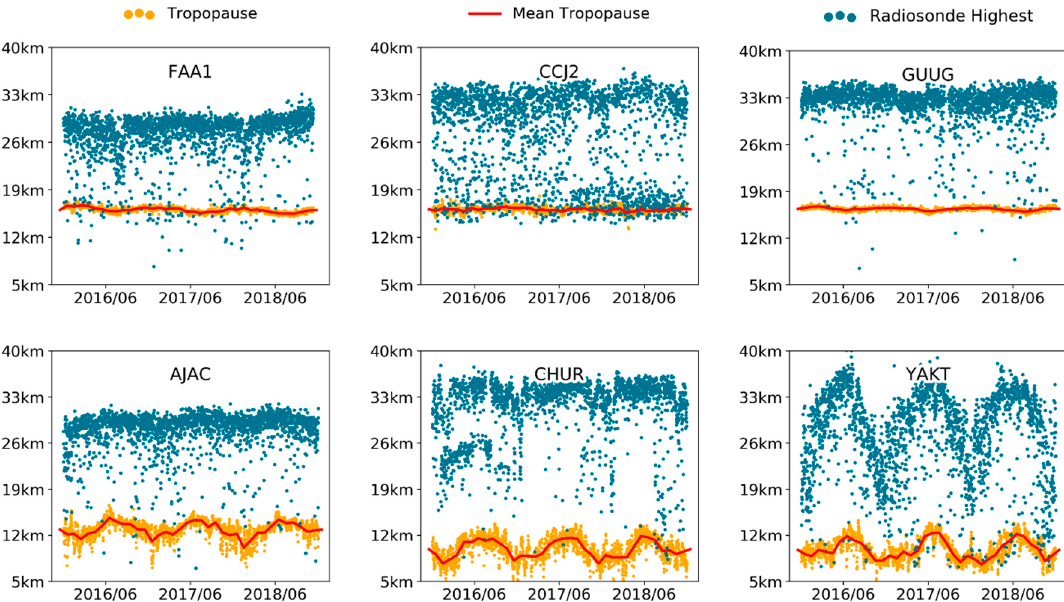
Figure 2. Example of data rejection for incomplete records by using monthly mean tropopause height estimates. Tropopause raw (in yellow), mean tropopause (in red), and highest radiosonde altitude (in blue) are shown for the stations of FAA1 on Tahiti island in the southern Pacific, CCJ2 on Ogasawara Islands in Japan, GUUG in Guam in the western Pacific, AJAC in Ajaccio in France, CHUR in CHURCHILL in Canada, and YAKT in Yakutsk of Russian. Radiosonde data records which ended below the red line were not used in this study (see Table 3 for radiosonde data rejection rates based on these mean tropopause heights).